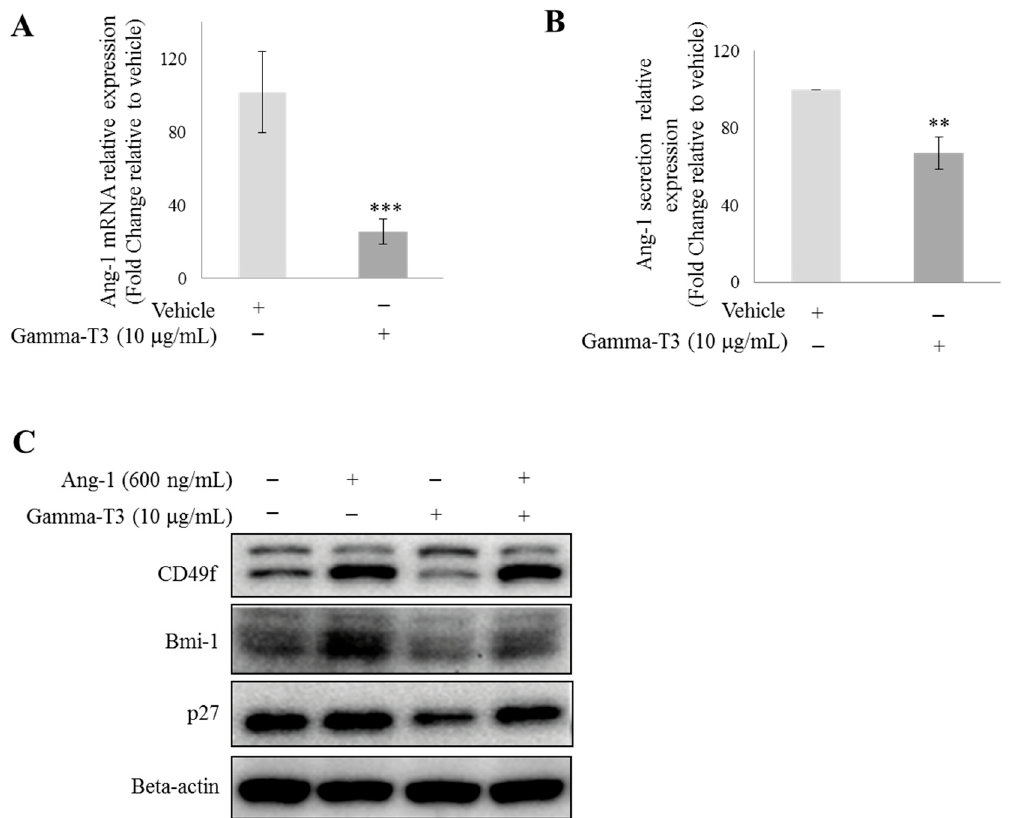
Figure 1. γ -T3 downregulates Ang-1 expression in prostate cancer cells. PC-3 cells were treated with 10 µg/mL γ -T3 for 72 h under a serum-free condition. ( A ) qRT-PCR and ( B ) ELISA analyses were performed to examine the effects of γ -T3 on Ang-1 expression in PC-3. ( C ) Addition of exogenous Ang-1 (600 ng/mL) partially restored the expression of CSC (CD49f and Bmi-1) and quiescence (p27) markers in the presence of γ -T3. Each experiment was repeated at least three times, and the results are presented as the mean ± SD. ( p values: ** < 0.005; *** < 0.0005).